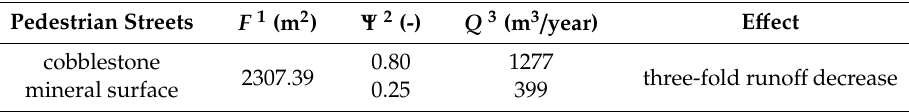
Table 6. Data summary for cobblestoned and mineral surface pedestrian